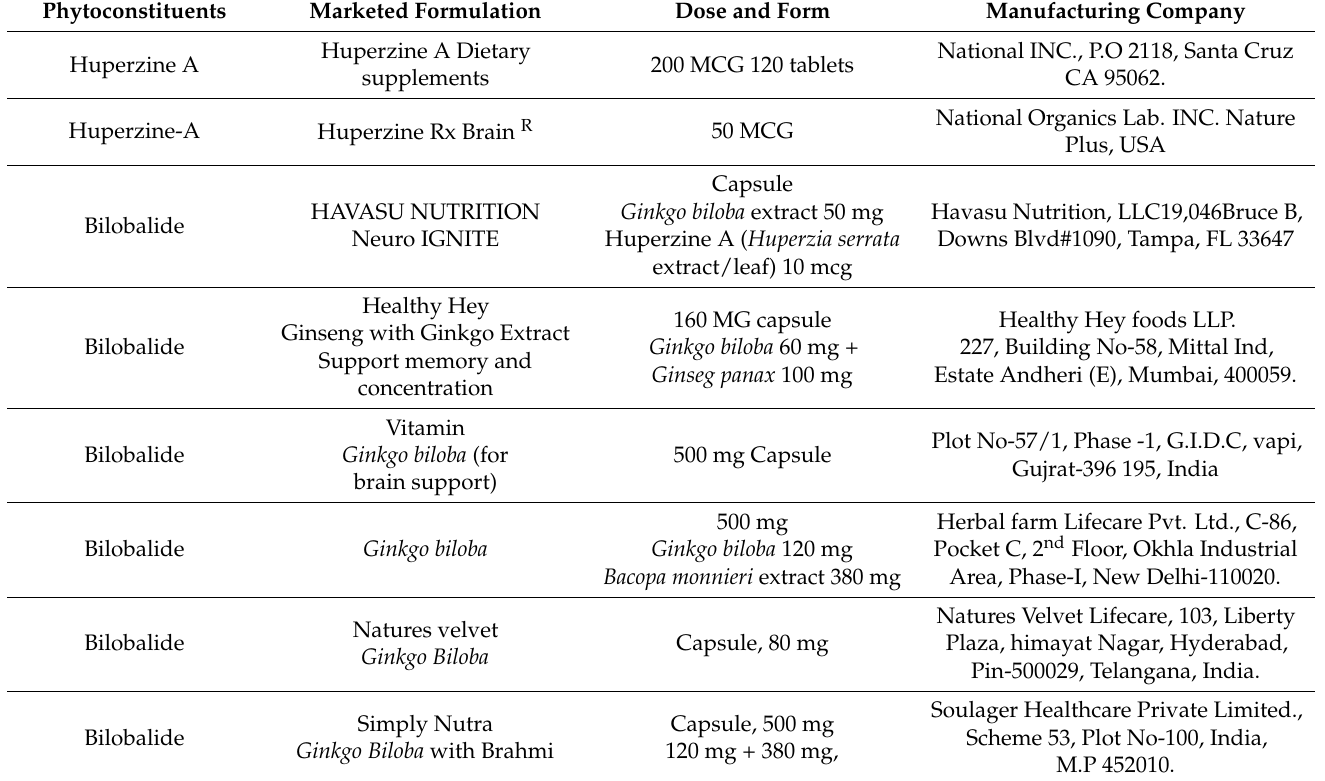
Table 2. Marketed formulation of the sesquiterpenes used for memory-enhancing